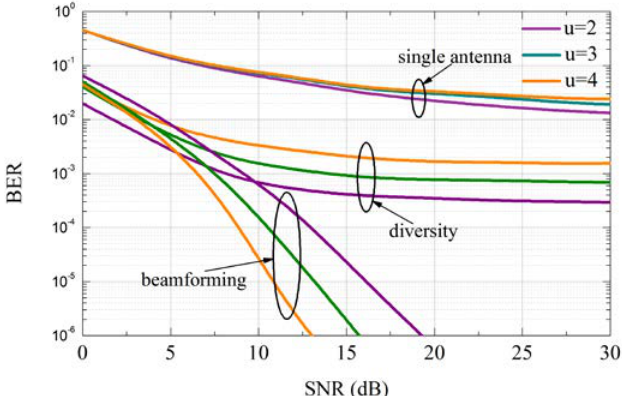
Figure 10. The relationship between the BER and the SNR of the three